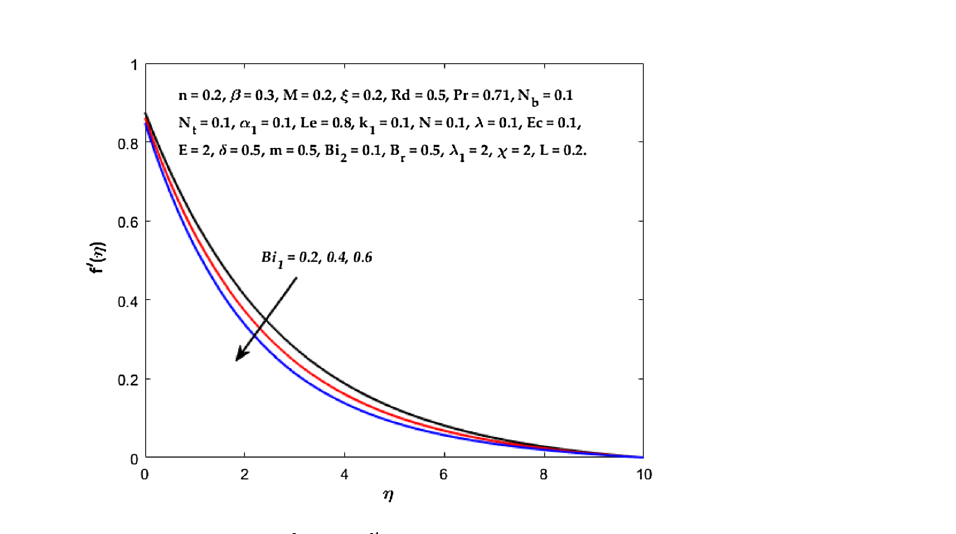
Figure 18. Diagram of Bi 1 v/s f ′ (η)